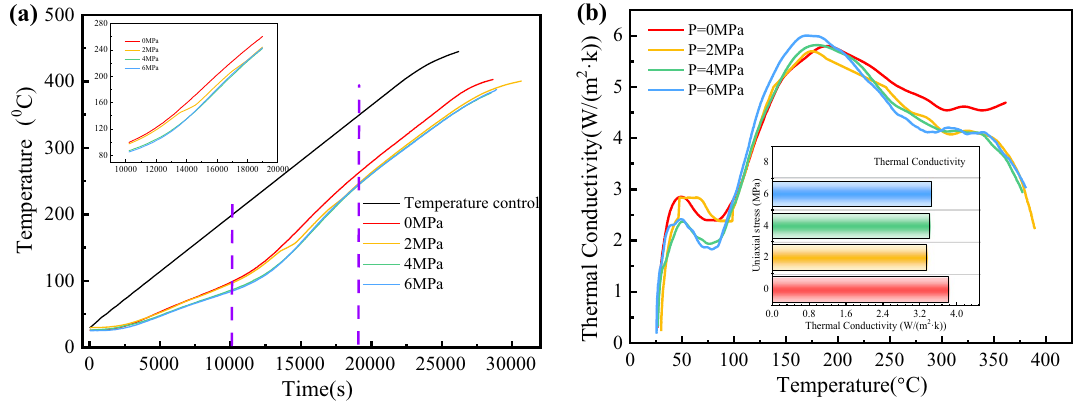
Fig. 4 Heat transfer and heating characteristics of coal in nitrogen atmosphere under different uniaxial stresses a Heating curve; b Thermal con-